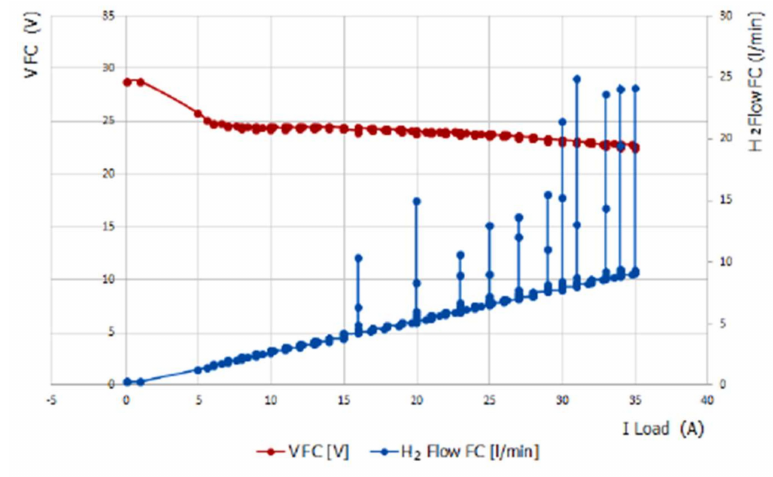
Figure 8. Characteristic curve of PEM fuel